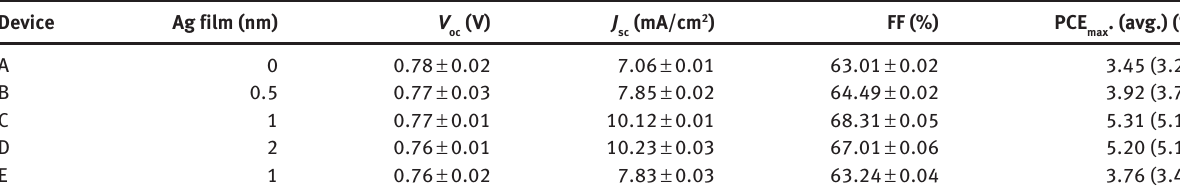
Table 1: Summary of the cell parameters obtained for different top-illuminated FOSCs.